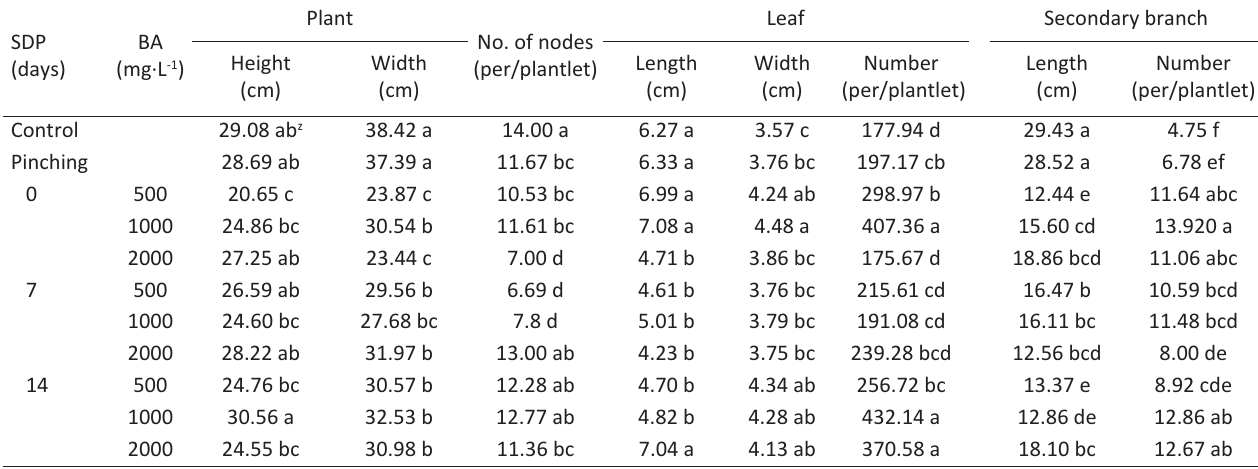
SDP= spraying days after pinching; BA= 6­benzylaminiopurine; z Mean separation within columns by Duncan´s multiple range test at p ＜